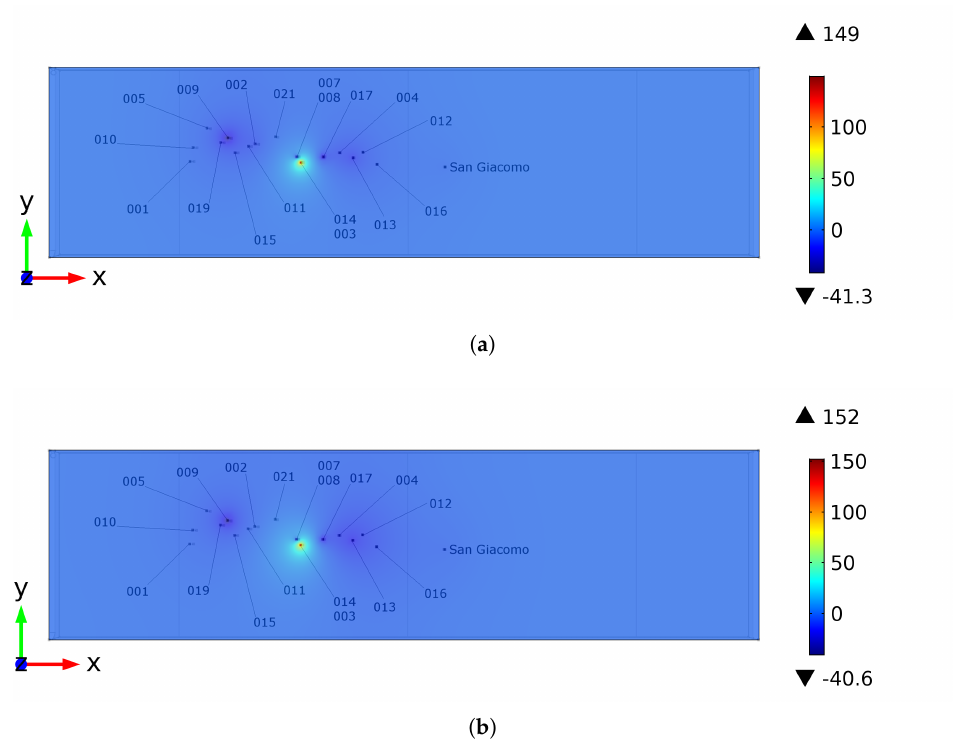
Figure 5. Cavone oilfield modeling: Pressure (bar) colour pattern computed on the top of the reservoir layer (parallel to x – y plane) with wells for the unsupported ( a ) and the supported ( b ) reservoir models.